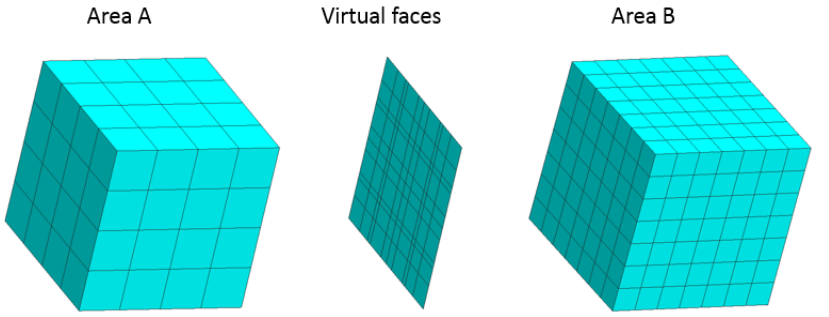
Figure 3. Creation of virtual faces.